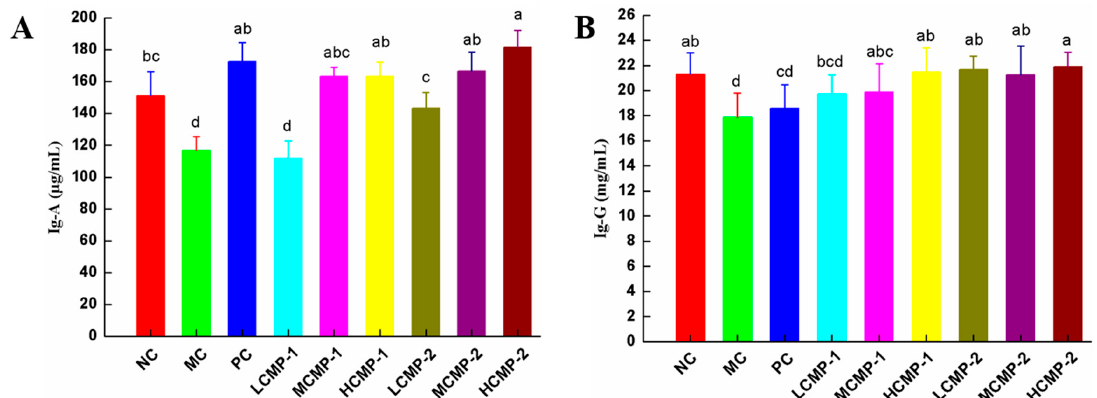
Figure 4. Effects of CMP-1 and CMP-2 on immunoglobulins Ig-A ( A ) and Ig-G ( B ) in serum. The data were expressed as means ± SD (n = 10). The significant differences ( p < 0.05) were marked as various superscript small letters (a–d).